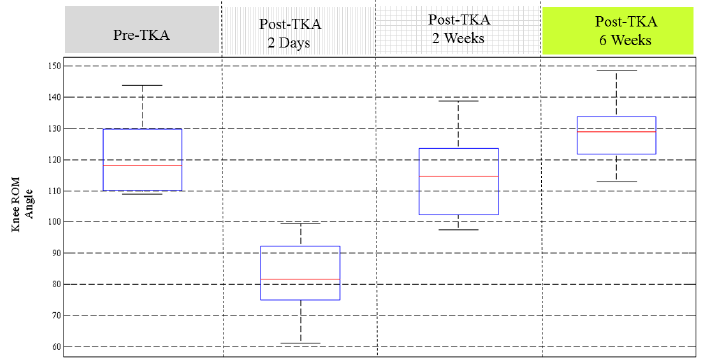
Figure 6. The recovery knee ROM angles collected from 18 TKA patients at four stages.